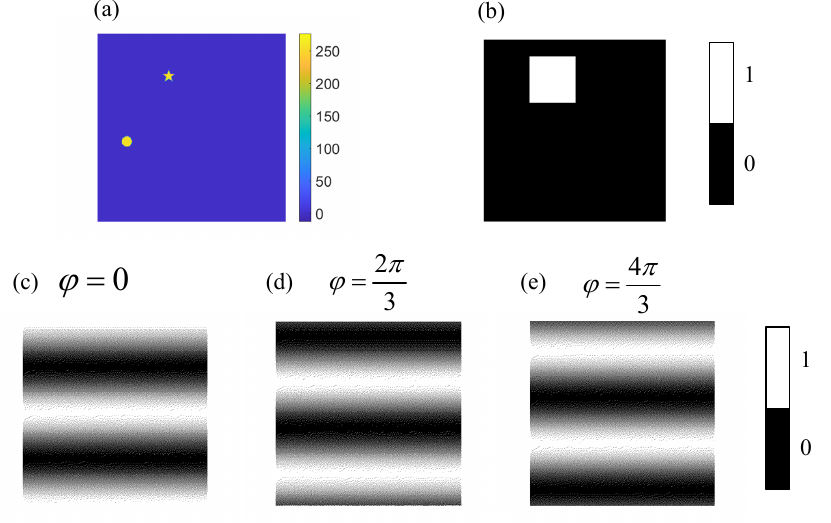
Figure 3. Illustrations of the measurement process. ( a ) is the target image with 256 × 256 pixels, ( b ) is the designed window function with 256 × 256 pixels. ( c – e ) are the binary Fourier patterns P bin ( 2 ,0, ϕ ) with 512 × 512 pixels used to calculate the Fourier coefficient F I 2 ( 2 N